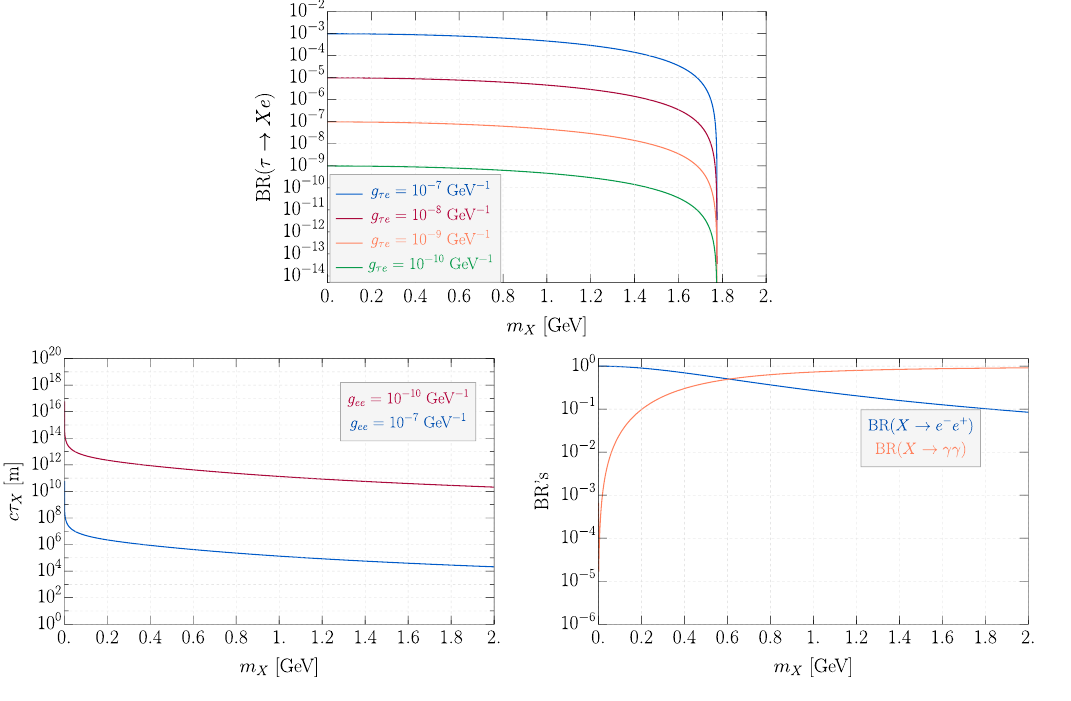
Figure 1 . Scenario 1. Top : branching ratio of τ → Xe vs. m X for g τe = 10 − 7 , 10 − 8 , 10 − 9 , 10 − 10 GeV − 1 . Bottom left : ALP proper flight distance cτ X vs. m X for g ee = 10 − 10 , 10 − 7 GeV − 1 . Bottom right : branching ratios of X → e − e + or γγ , as a function of m X .